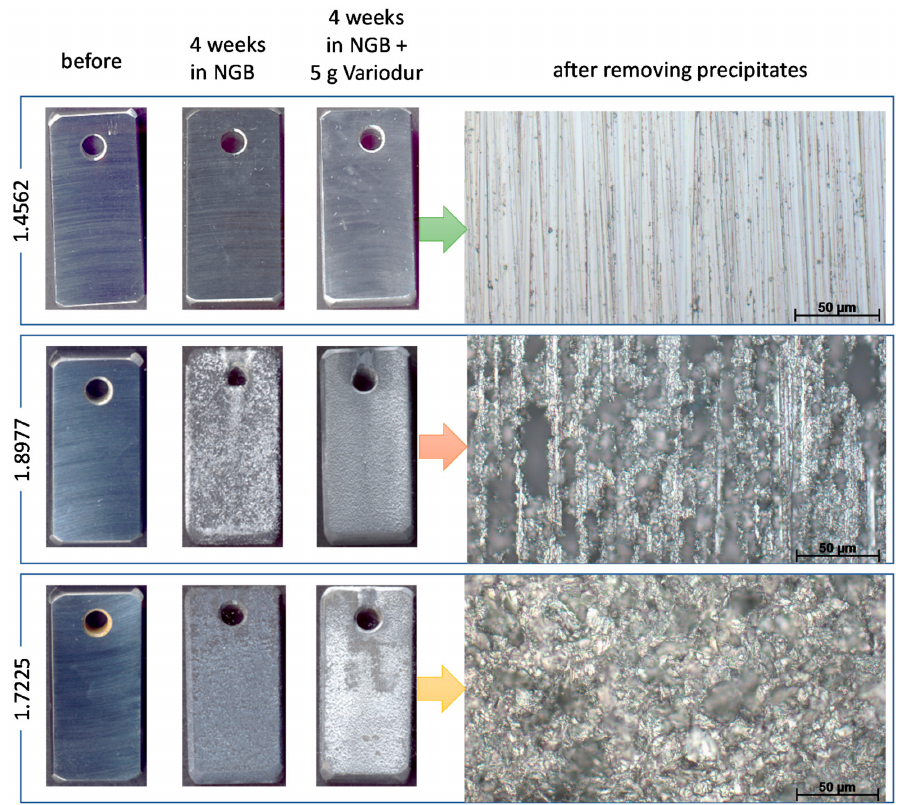
Figure 14. Macrophotographs ( left ) and stereomicroscope pictures ( right ) of 4-week-exposed steel specimens in simulated pore water with and without mixing with aquifer fluid. The total volume of the test solution in each test was 500 mL, and 5 g of Variodur was